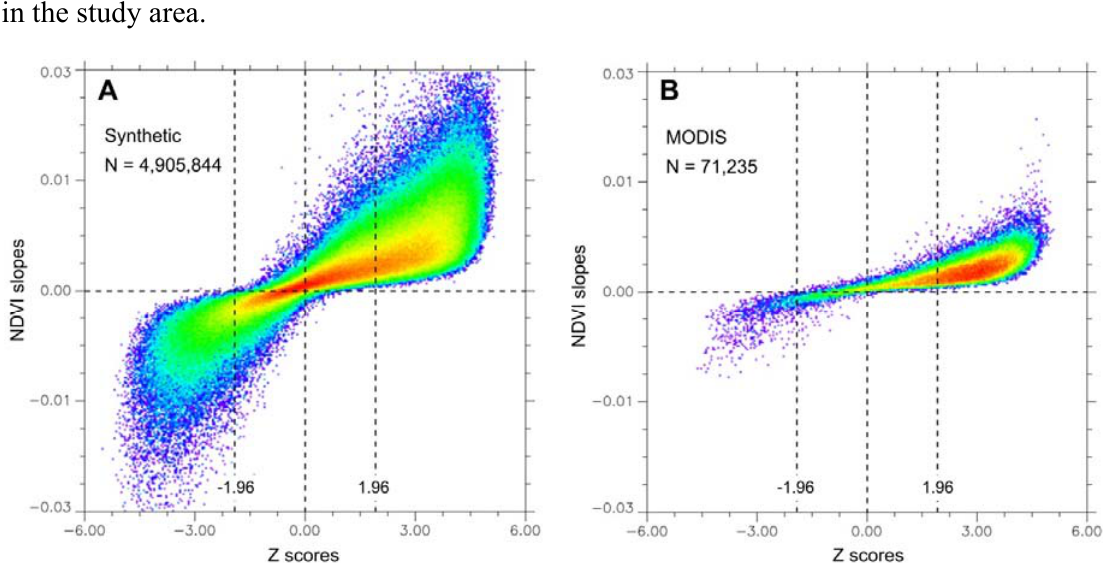
Figure 7. Scatterplots of the significance (Z scores) of NDVI trends versus the magnitude of NDVI trends (NDVI slopes) derived from ( A ) synthetic and ( B ) MODIS dense NDVI time series (2000–2011). Pixels beyond the two vertical dashed lines of Z = − 1.96 and Z = 1.96 are characterized by a significant trend. N is the total number of vegetated pixels in the study